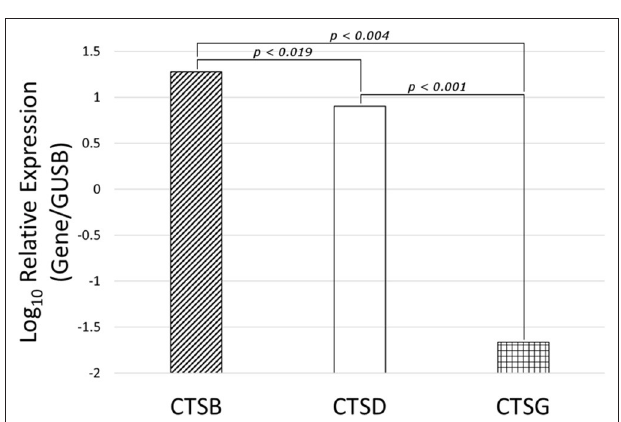
FIGURE 6 | Expression of cathepsins cathespsin B (CTSB), cathepsin D (CTSD) and cathepsin G (CTSG) mRNA transcripts in WHO grade I meningioma samples from six patients, normalized over the housekeeping gene GUSB and presented as Log 10 Relative Expression. Paired t -tests demonstrated significantly higher levels of expression of cathepsin B ( p < 0.004) and cathepsin D ( p < 0.001) than cathepsin G. Cathepsin B and cathepsin D were only marginally different to each other ( p > 0.019). cathepsin B and cathepsin D and possibly cathepsin G, are also expressed and cathepsin B and cathepsin D are active in the same TSCs in WHO grade I MG.